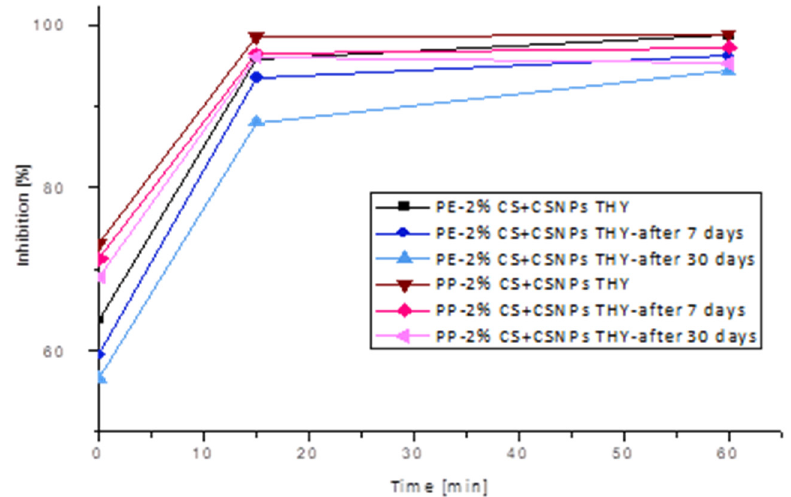
Figure 10. Antioxidative activity of UV/ozone-activated PE and PP foils, coated with 2% chitosan and chitosan nanoparticles with incorporated thyme extract directly after application, after seven days and after one month.